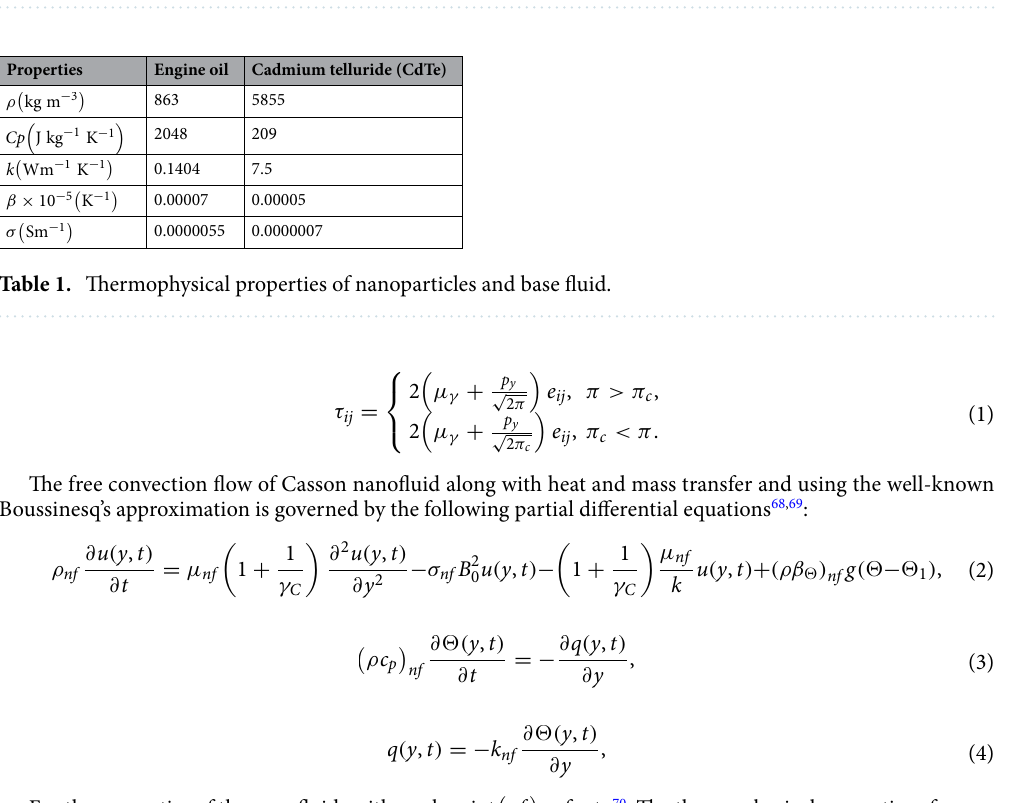
Figure 1. Schematic diagram.